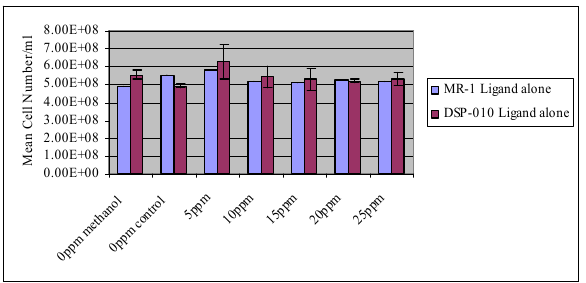
Figure 5: Effects of various concentrations of uncomplexed thiosemicarbazone ligand on Shewanella oneidensis MR-1 and DSP-010 grown aerobically in LB broth. Mean cell/ml was determined at 37 ˚ C after a 48 hour time period for three independent experiments. Error bars are for standard